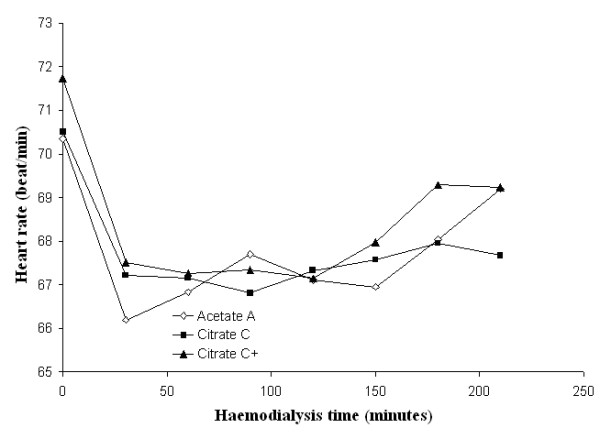
Heart rate. Heart rate as a function of the haemodialysis time using, respectively, acetate (A) (empty diamonds), calcium uncorrected citrate (C) (black squares) and calcium supplemented citrate dialysate (C+) (black triangles).